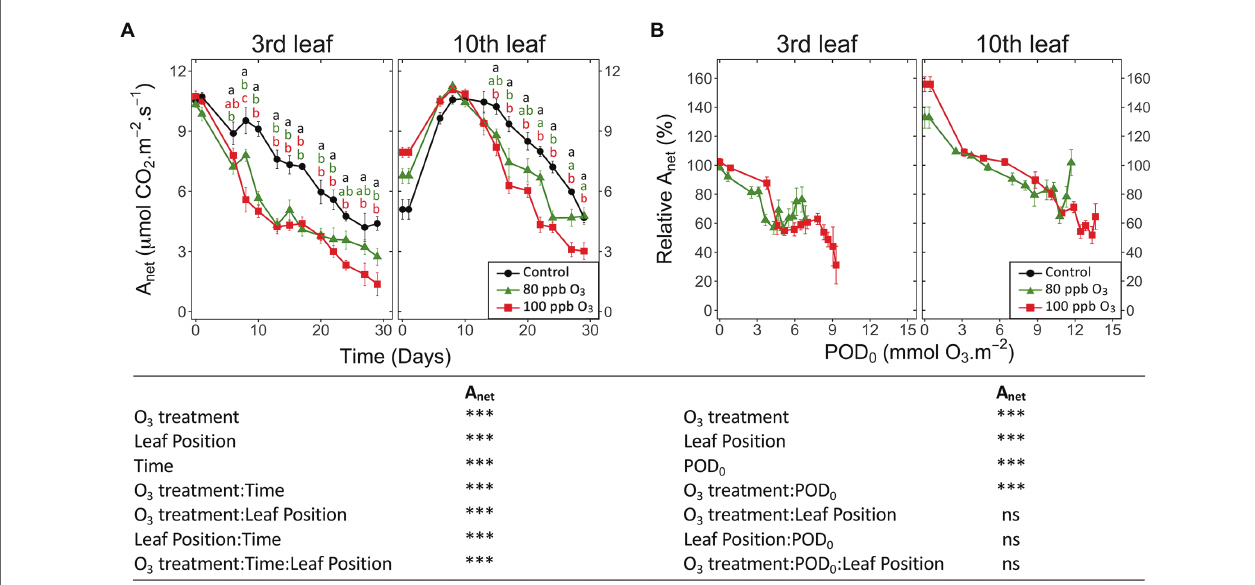
FIGURE 2 | Dynamics of changes in the net CO 2 assimilation (A net ) of hybrid poplar leaves ( Populus tremula x alba ), as a function of assessment time (A) , phytotoxic O 3 dose (POD 0 ; B ), O 3 treatment (charcoal-filtered air ● , 80 ppb O 3 ▲ , 100 ppb O 3 ◼ ), leaf position and interactions [model: lmer(variable) ~ O 3 treatment ∗ leaf position ∗ time + (1 | tree / chamber); ∗∗∗ p ≤ 0.001; ns, not significantly different]. Values represent means ± SE, n = 6. Different letters indicate significant differences between treatments at a given assessment date ( post-hoc Tukey’s Honest significant difference, p ≤